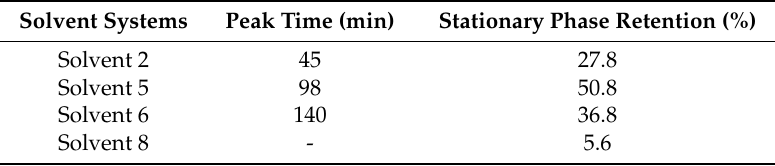
Table 2. Separation effect of different solvent systems on the rutin